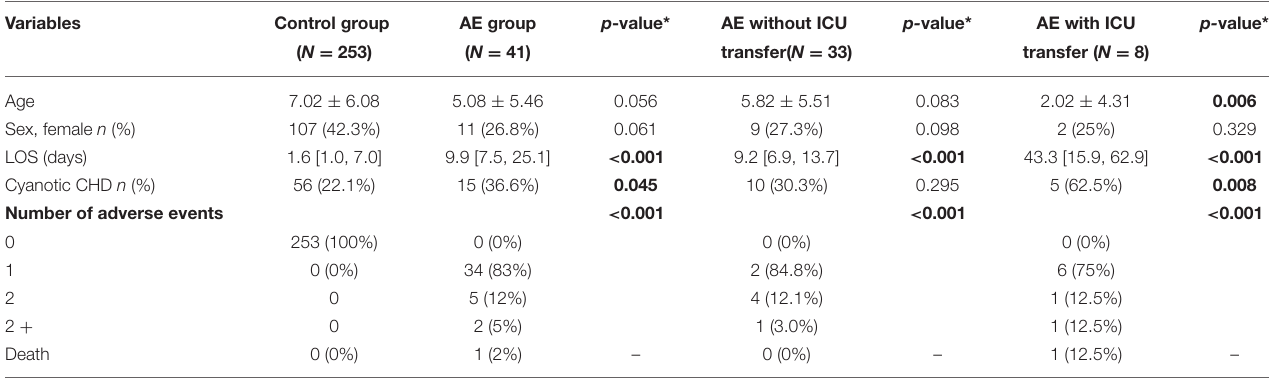
TABLE 1 | Demographic and clinical data of the patients included the 1st year pilot study of CORTEX “traffic light”. Variables Control group AE group p